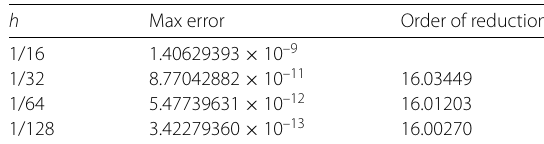
Table 3 Maximum errors for the solution of Problem 3